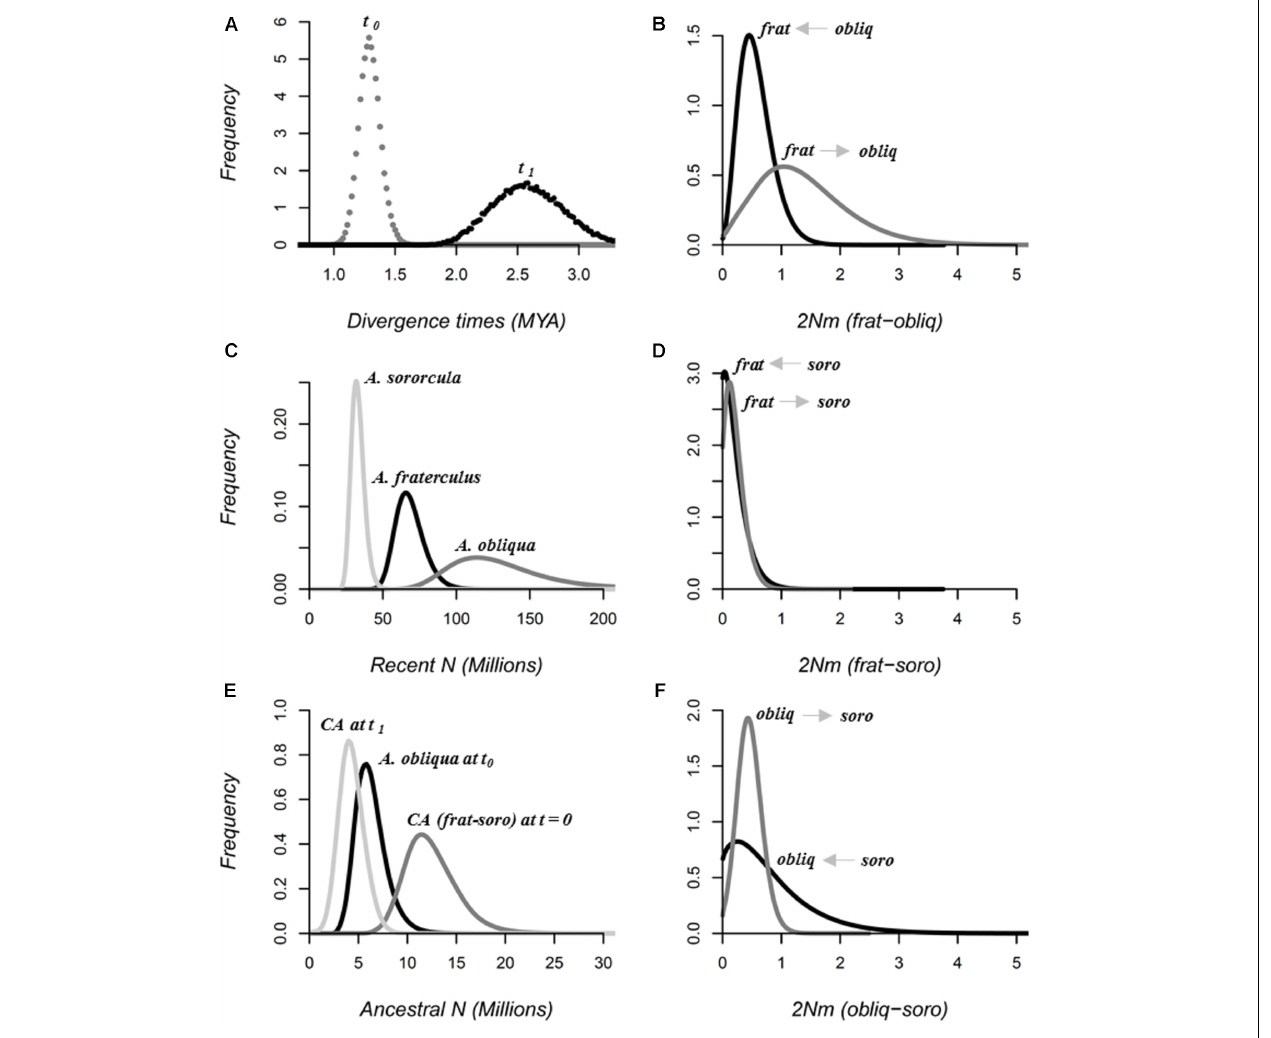
FIGURE 4 | Marginal posterior probability distributions for speciation parameters in demographic scales estimated by simulations of the IM model using 20 loci in IMa2 software. (A) Divergence times in MYA, between A. fraterculus and A. sororcula ( t 0 ), and between these two species and A. obliqua ( t 1 ). Effective population sizes in millions of individuals ( N ) for (B) each of the species ( Recent N ) as well as (C) their common ancestors ( CA , Ancestral N ). Bidirectional migration rates ( 2Nm ) for each species pair: (D) A. fraterculus vs. A. obliqua ( frat-obliq ), (E) A. fraterculus vs. A. sororcula ( frat-soro ) and (F) A. obliqua vs. A. sororcula ( obliq-soro ). Direction of migration is indicated in the graphics. All parameters are scaled using mutation rates per locus per year estimated using the split time reported for Tephritidae ( ∼ 36 million